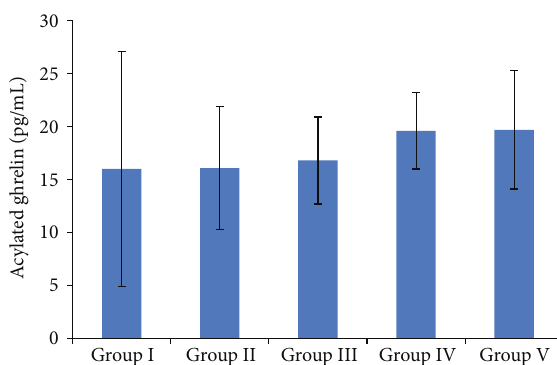
Figure 1: Serum acylated ghrelin levels in relation to BMIs. Group I: low-weight; Group II: normal-weight; Group III: overweight; Group IV: obese; Group V: morbidly obese. 𝑃 < 0.005 for Group I versus Group IV and Group V.